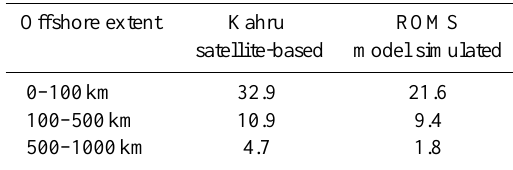
Table 1. Comparison of simulated and satellite observation-based